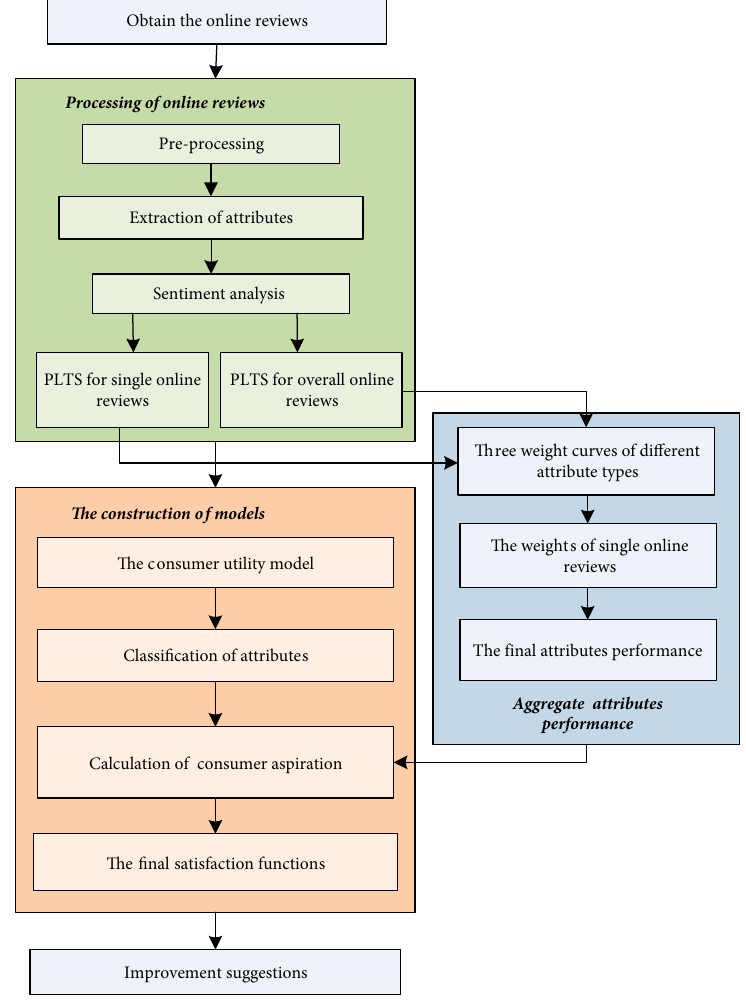
Figure 9. The proposed framework based on online